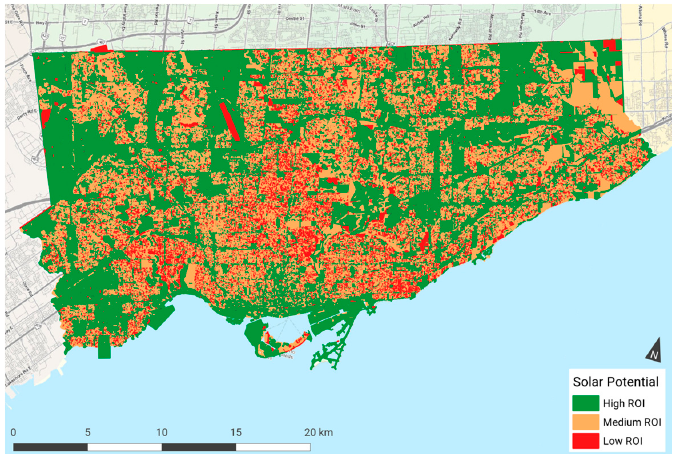
Figure 6. Solar potential for properties within the City of Toronto.